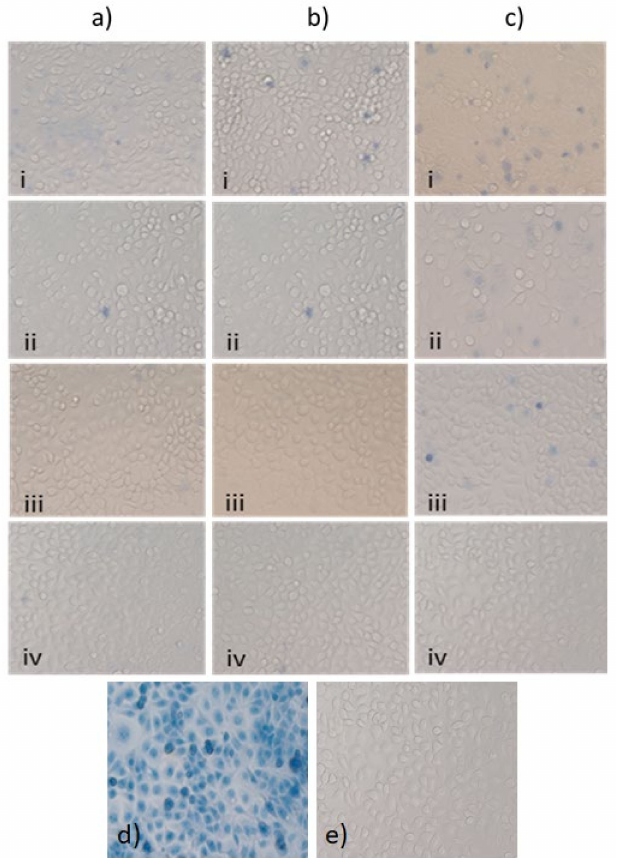
Figure 7. The effect of ( a ) Cu-SiQDs, ( b ) Sc-SiQDs, and ( c ) Zn-SiQDs, at (i) 250 µ g/mL, (ii) 32 µ g/mL, (iii) 16 µ g/mL, (iv) 1 µ g/mL, and the ( d ) positive control and ( e ) negative control on HCECs, as assessed by the trypan blue exclusion test. (Magnification 40 ×